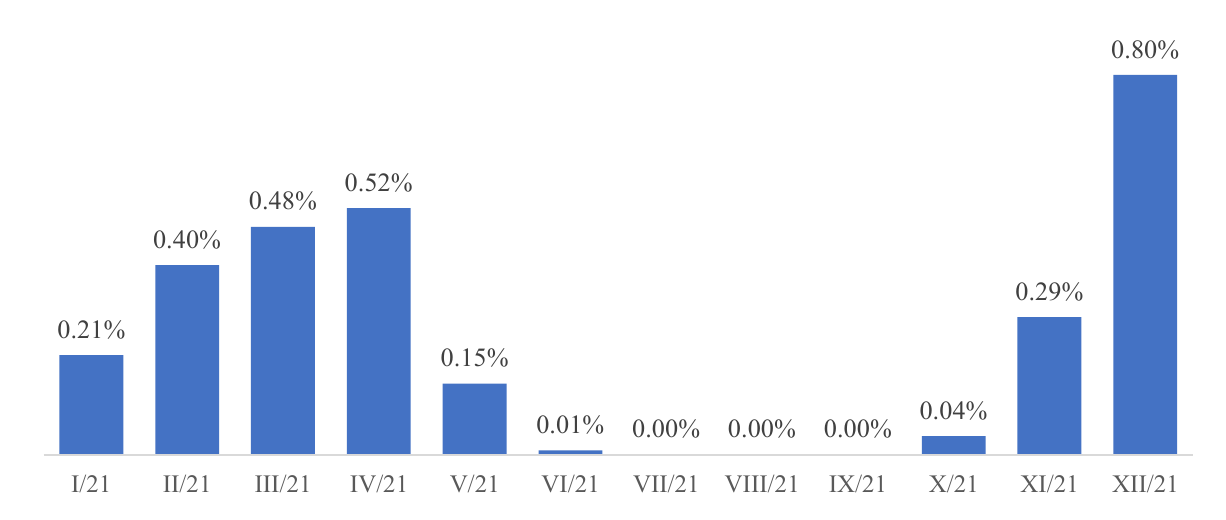
Figure 1. The percentages of infected inmates in individual months of 2021.